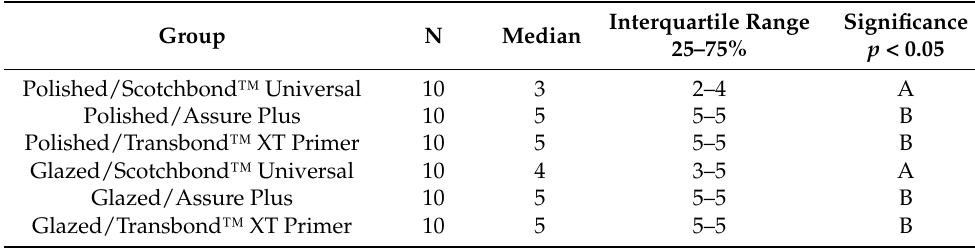
Table 5. Descriptive statistics of ARI scores for lithium disilicate glass ceramics groups. In the significance column, different letters label statistically significant differences.